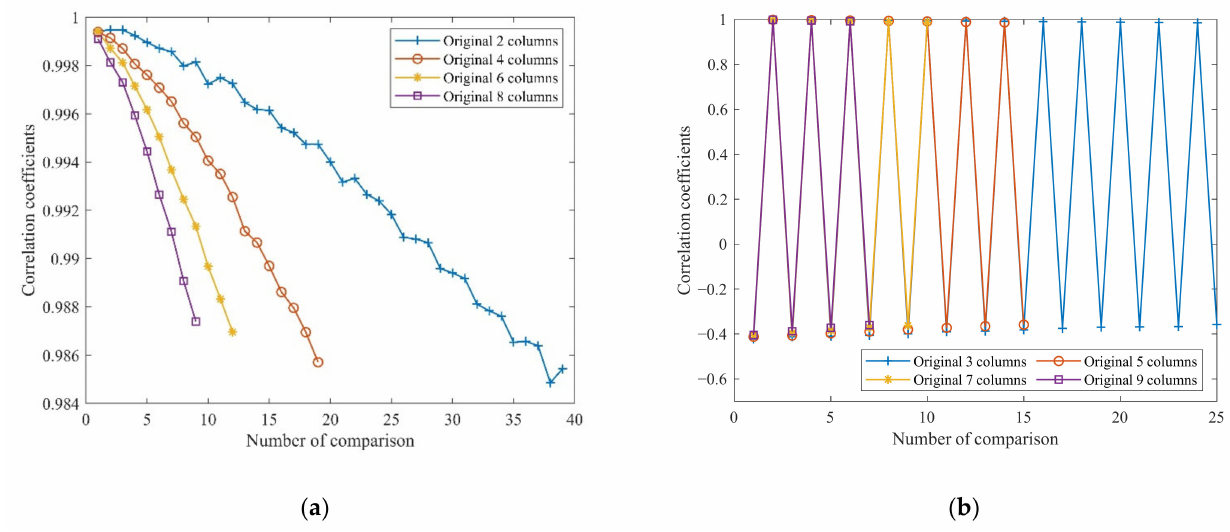
Figure 8. The correlation coefficients of the matrix of ( a ) even columns and ( b ) odd